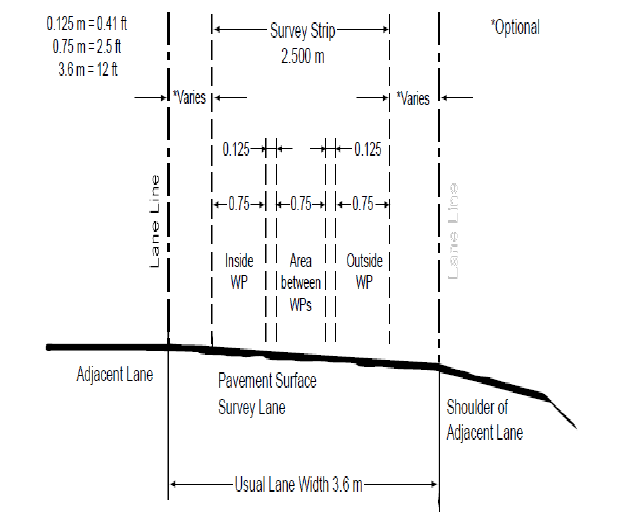
Figure 1 . Wheel path definition by AASHTO 2 (Definition